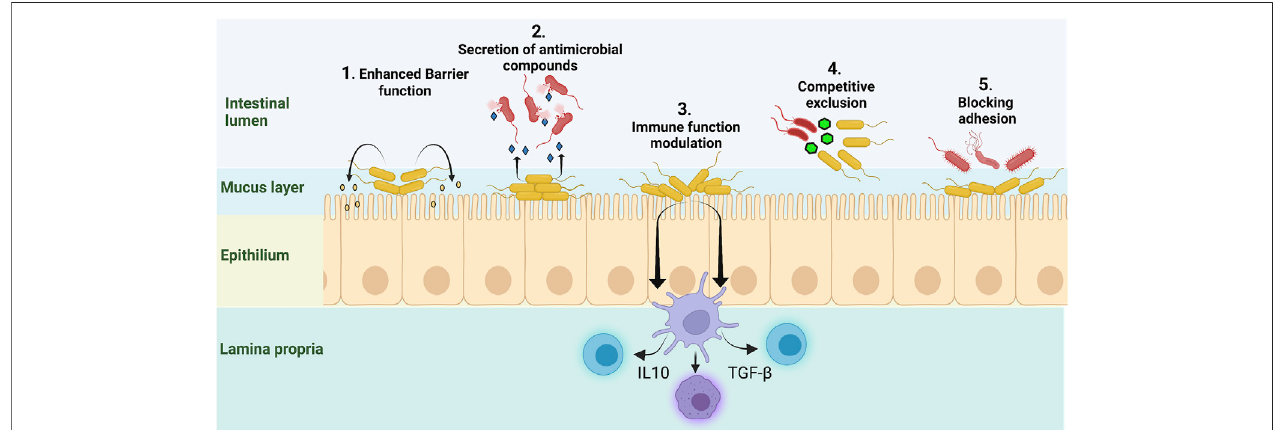
FIGURE 2 | Native probiotic microbes provide bene fi cial activities. 1) Secretion of short chain fatty acids (SCFA) and other small molecules can enhance epithelial barrier function. 2) Probiotic strains can secrete anti-microbial peptides and other small molecules that inhibit pathogenic bacteria. 3) Probiotic strains can modulate in fl ammatory responses through in fl uence on dendritic cells and T-cells to improve immune function and dampen secretion of in fl ammatory cytokines. 4) Probiotics compete with pathogens for space and nutrients thus limiting their proliferation in a crowded gut environment. 5) Resident microbiota and probiotics inhibit pathogen adhesion and colonization of the gut walls. Figure constructed using